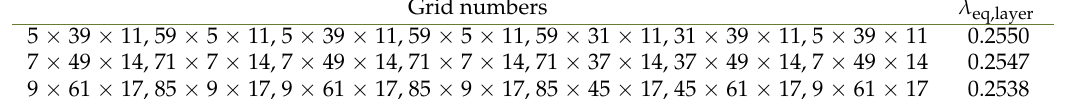
Table 1. Results of the different grids tested Grid numbers